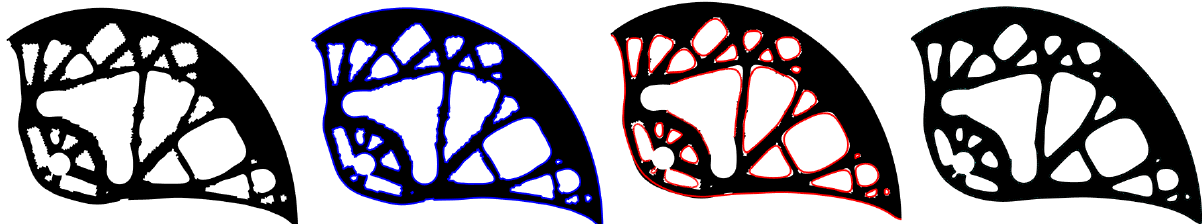
Figure 10. Four steps of the smoothing process (from the left): (i) importing the calculated shape, (ii) analyzing the external shape, (iii) approximation of external nodes, and (iv) generation of the smoothed geometric model.